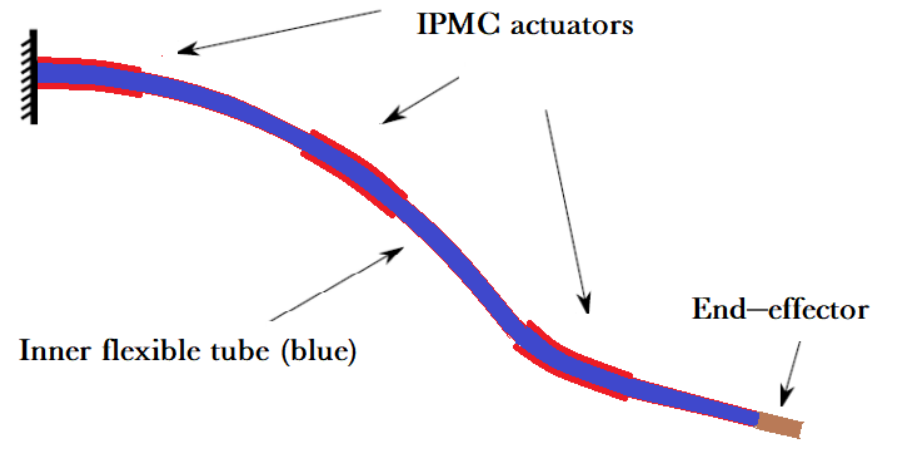
Figure 1. IPMC-actuated compliant